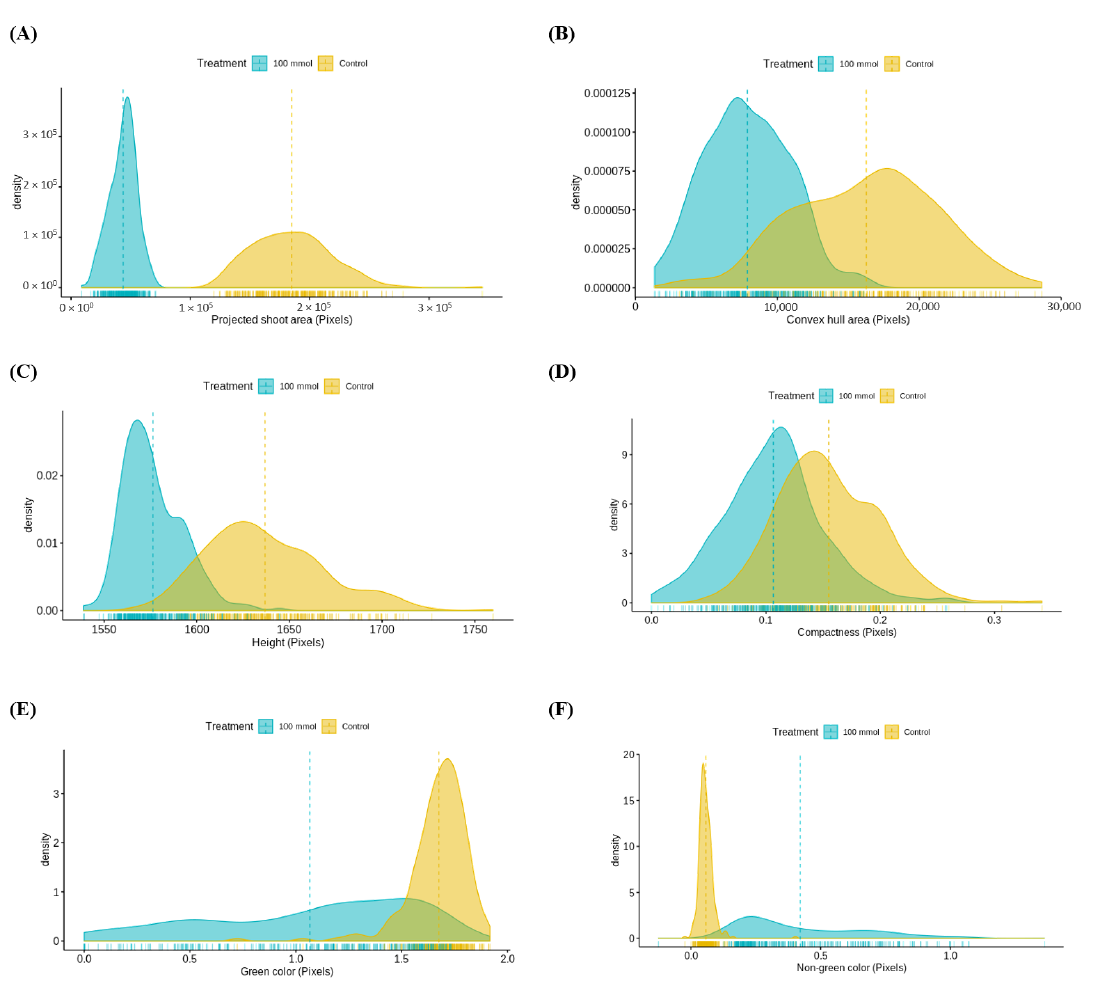
Figure 6. Distribution curves of non-destructive phenotypic traits of individual lentil accessions: Figure 6 ( A ) projected shoot area, ( B ) convex hull area, ( C ) height, ( D ) compactness, ( E ) green color, and ( F ) non-green